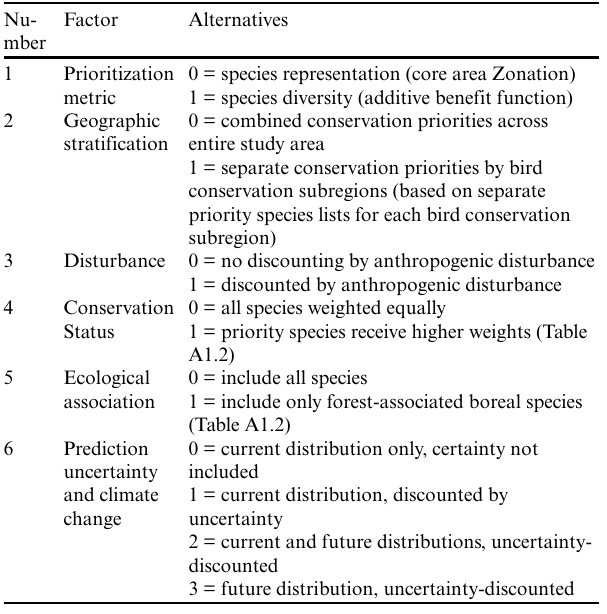
Table 1 . Factors manipulated to develop alternative scenarios for Zonation analysis. Each of the 128 scenarios evaluated (Table A1.1) represents a unique combination of